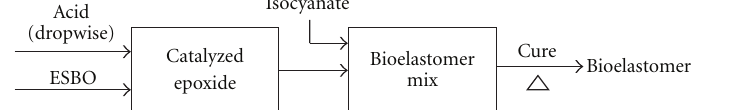
Figure 2: Schematic of bioelastomer synthesis. Oxirane opening reaction is performed at room temperature with constant